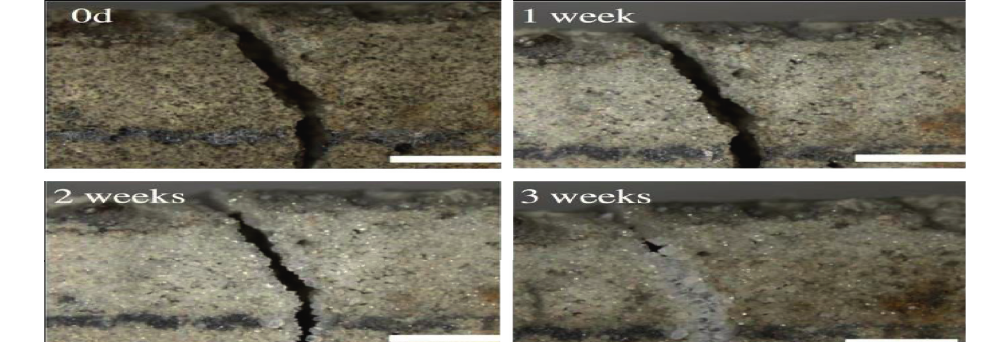
Figure 1: Phase of crack healing with respect to time [7].